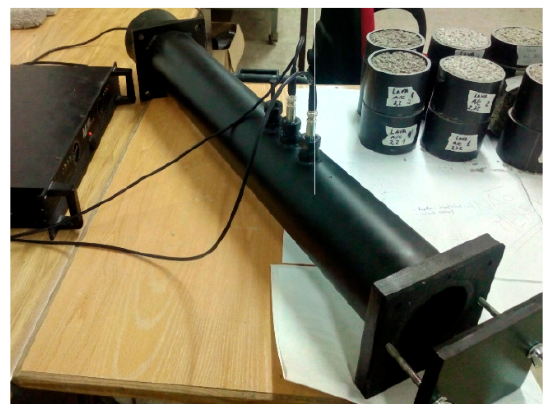
Figure 6. Impedance tube with 100 mm internal diameter.